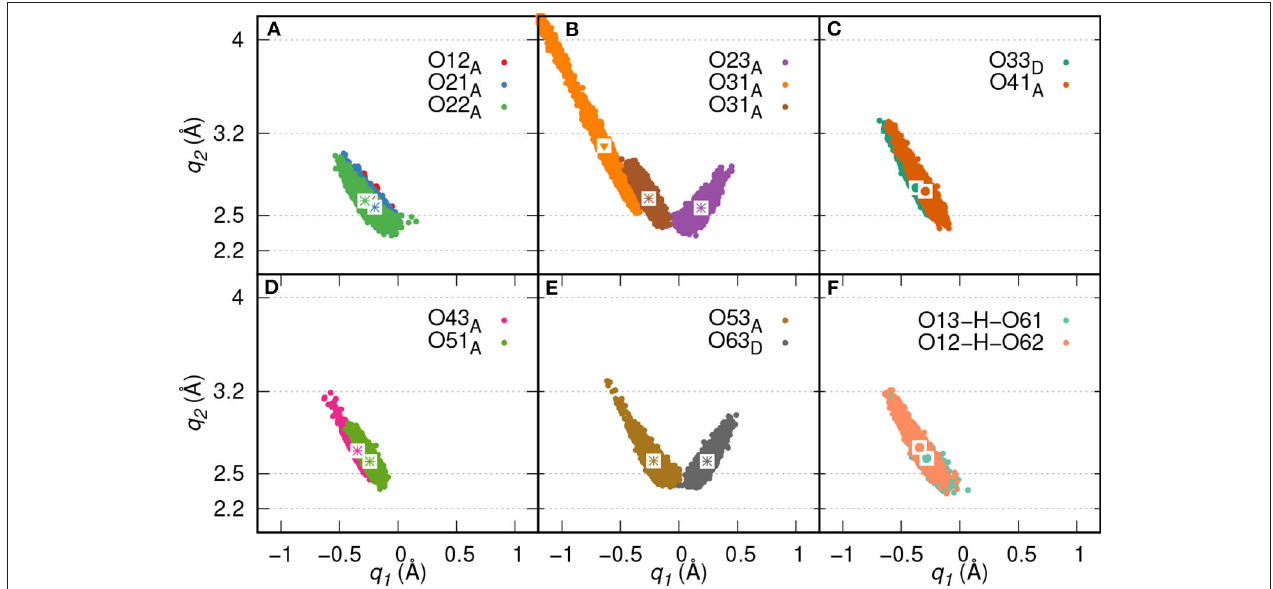
FIGURE 6 | HB correlation q 2 vs. q 1 of HBs formed between IHP and water (A–E) and between P1 and P6 phosphate groups (F) along trajectory of IHP’s M(1) motif. The average q 1 and q 2 coordinate pairs are shown as points in white square boxes. A strong to moderately strong HB is denoted as * while a moderately strong HB and a moderately strong to weak HB are denoted as • and H ,